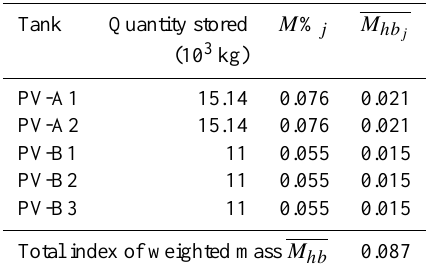
Table 5. Quantity of substance stored and corresponding index of weighted mass used in the